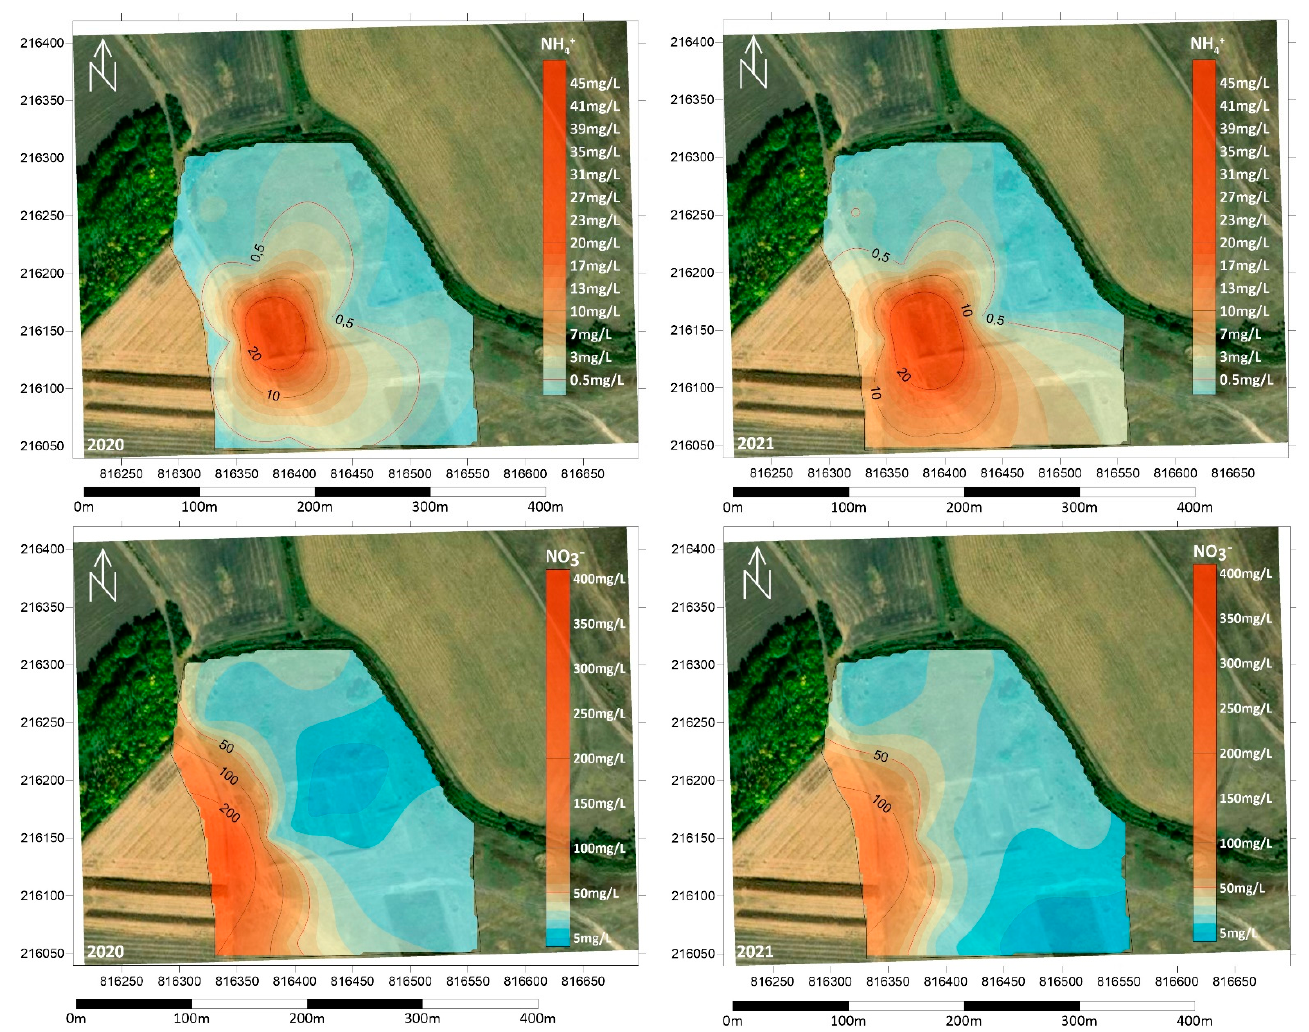
Figure 7. Spatial distribution of NH 4+ and NO 3 − concentration in the summers of 2020 and